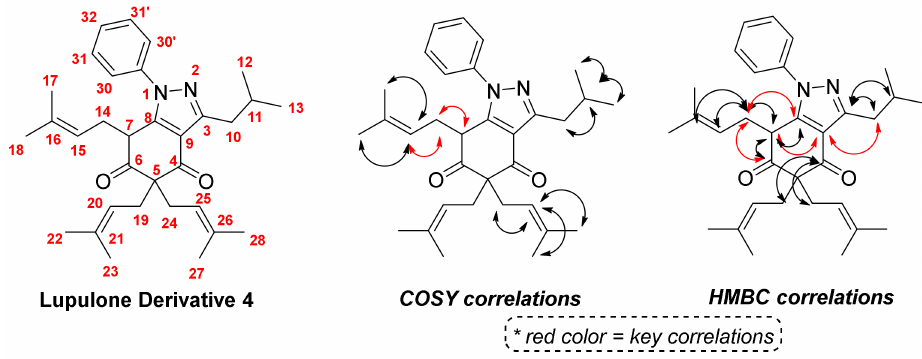
Figure 3. COSY and HMBC correlations in the lupulone derivative 4